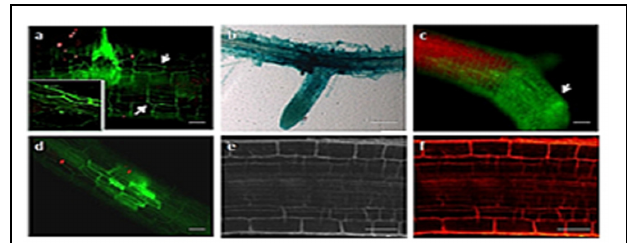
FIGURE 4 | Early colonization stages of Arabidopsis roots by U. virens . (a) hyphae growing along the epidermis parallel to the longitudinal axis of the root and forming lateral hyphopodia (arrow), 2 dpi. The inset shows magnification of the upper section of the root; (b) younger GUS stained hyphae extensively colonize the root surface, forming a network around the root; (c) heavy colonization of the Arabidopsis root by U. virens after 10 dpi; (d) root cells become colonized by hyphae in a mosaic pattern, leaving some cells uninfected after 10 dpi; (e) root of the uninfected Arabidopsis plant under bright field microscopy (Control); (f) uninfected Arabidopsis root under epifluorescence microscopy. Bars = 100 μ m (a,c,d) , 40 μ m (e,f) and 50 μ m (b) .